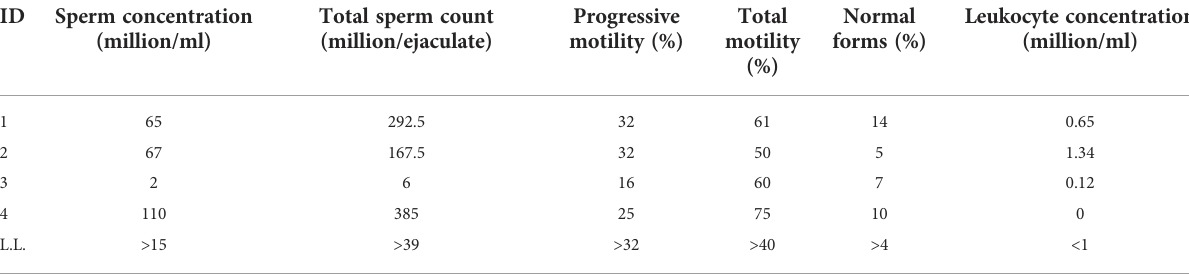
TABLE 1 Conventional sperm parameters of the semen samples of the men enrolled in this study. ID Sperm concentration Total sperm count (million/ml)